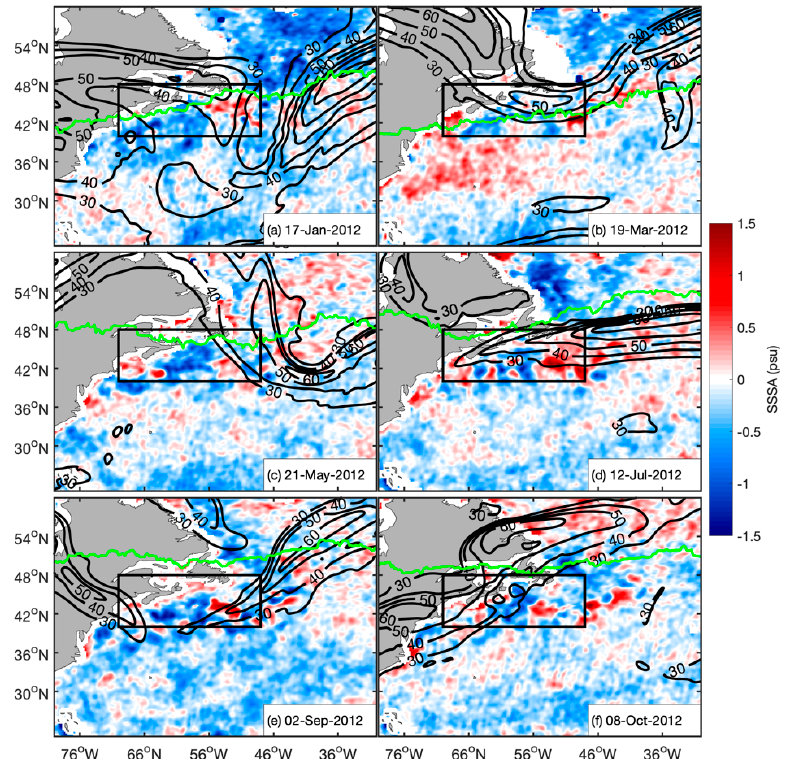
Figure 5. Spatial map of SSSA (psu) in the NW Atlantic throughout 2012. Black contour lines indicate wind speeds (m/s) at 300 hPa and the location of the Jet Stream. Green lines show the mean Jet Stream position based on the daily wind speed at 300 hPa from 1981–2020. Time series data was averaged over 40–48°N and 70–48°W indicated by the box.